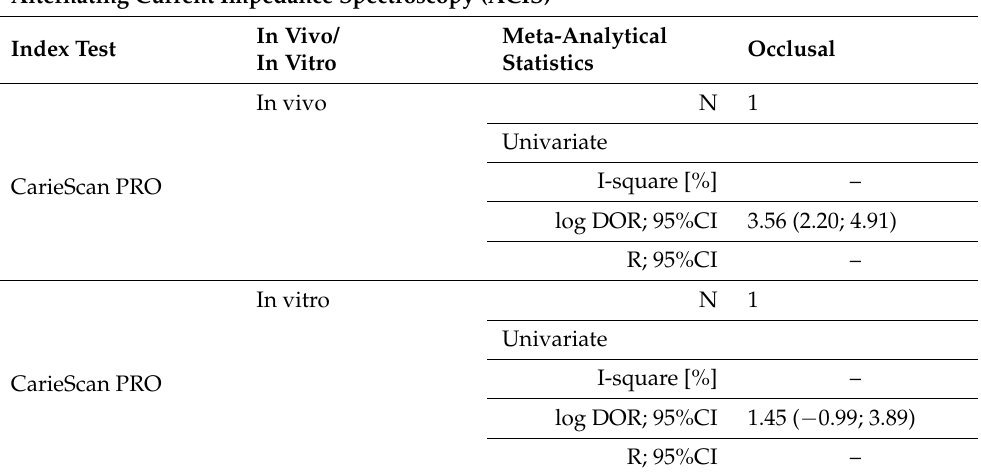
Table 11. Descriptive results for the alternating current impedance spectroscopy (ACIS) technology, CarieScan PRO